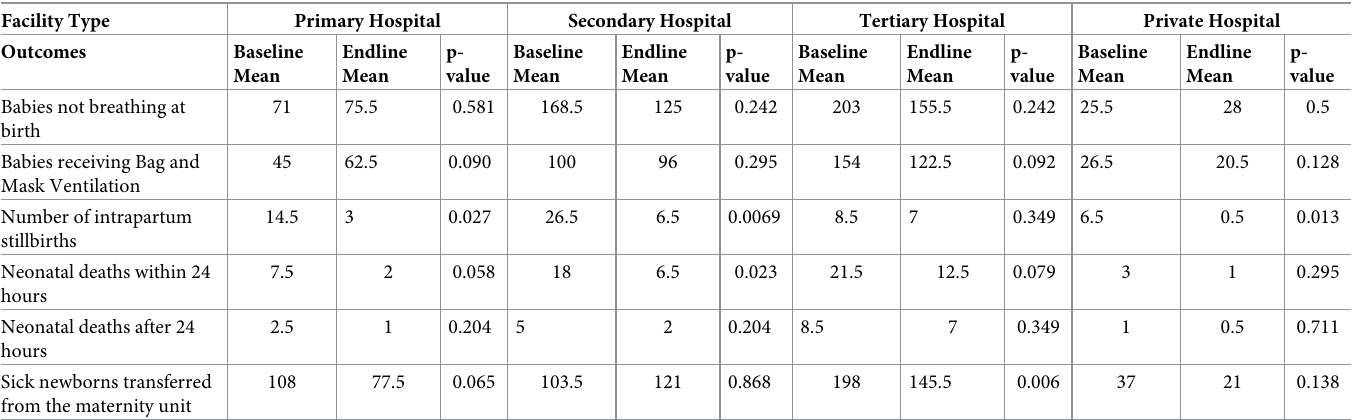
Table 4. T- test scores of perinatal outcomes by